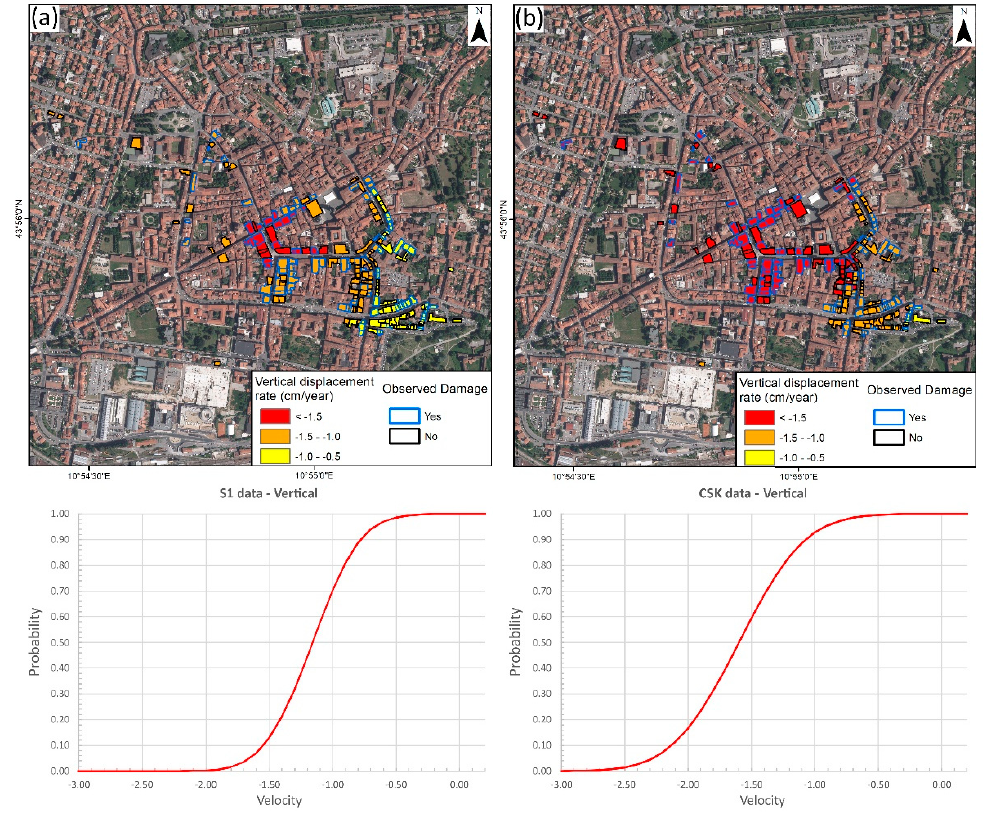
Figure 7. Mean vertical velocities of the inspected buildings in S-1 ( a ) and CSK ( b ), and fragility curves of the damaged buildings for them.